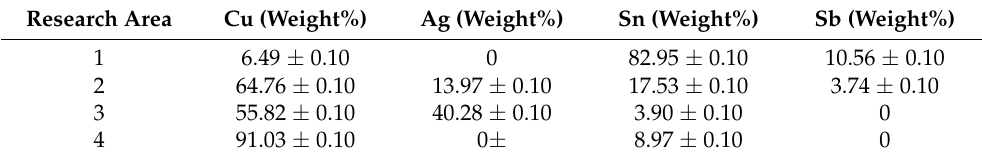
Table 4. The cross-section elemental composition of the running-in coatings of specimen